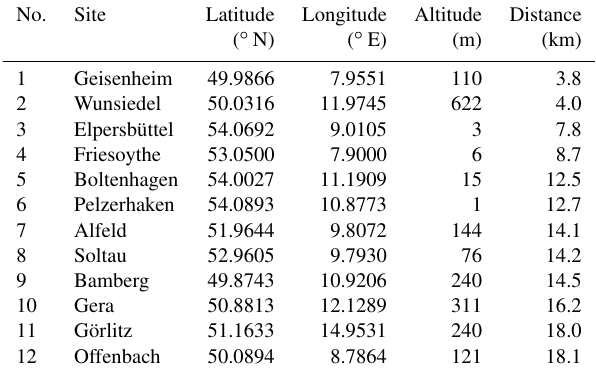
Table 2. Ceilometer sites within a distance of 20km to the nearest IFS model grid point; altitude is given in meters above mean sea level. The distance to the nearest model grid point (in km) is given in the last